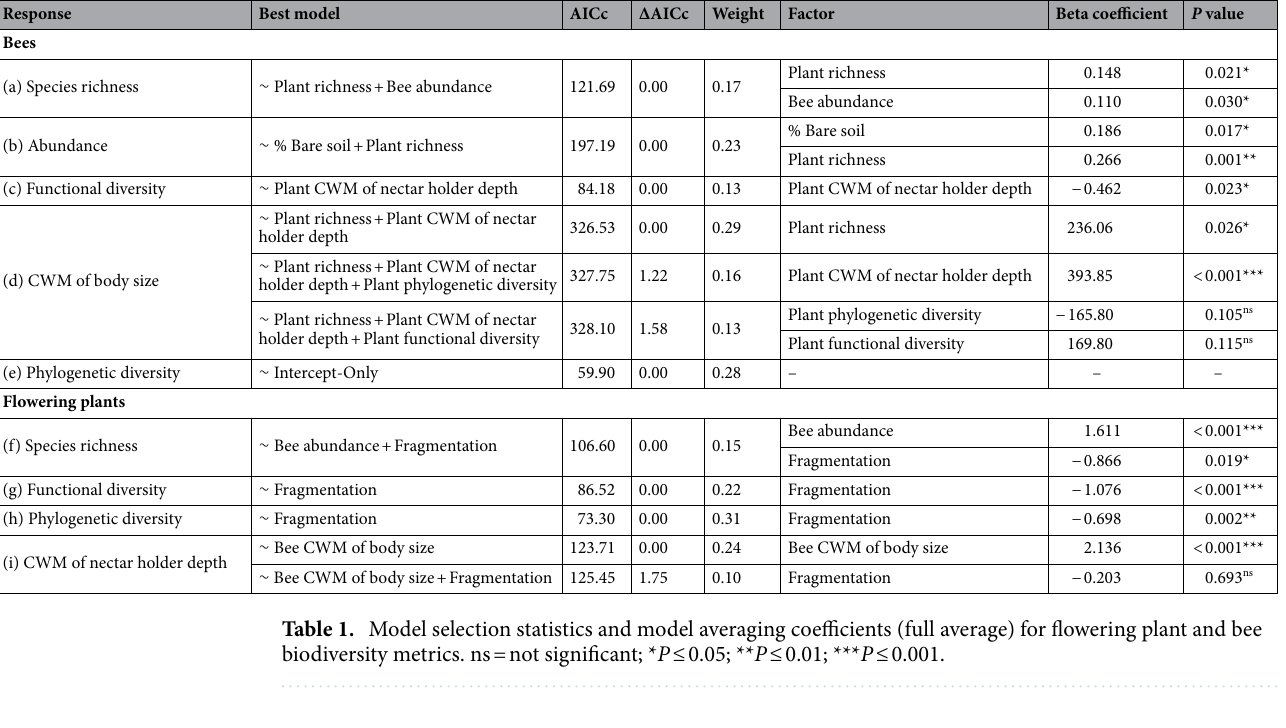
explored the main flowering plant community diversity metrics and environmental drivers of bee diversity. We found a variety of relationships between bee communities and flowering plant diversity, bare soil cover and landscape heterogeneity. Firstly, bee species richness was positively related to flowering plant richness (Table 1; Fig. 1a). Overall bee abundance was also positively associated with flowering plant richness and the percentage of bare soil cover (Table 1; Fig. 1b,c). Bee functional diversity decreased with increasing community weighted